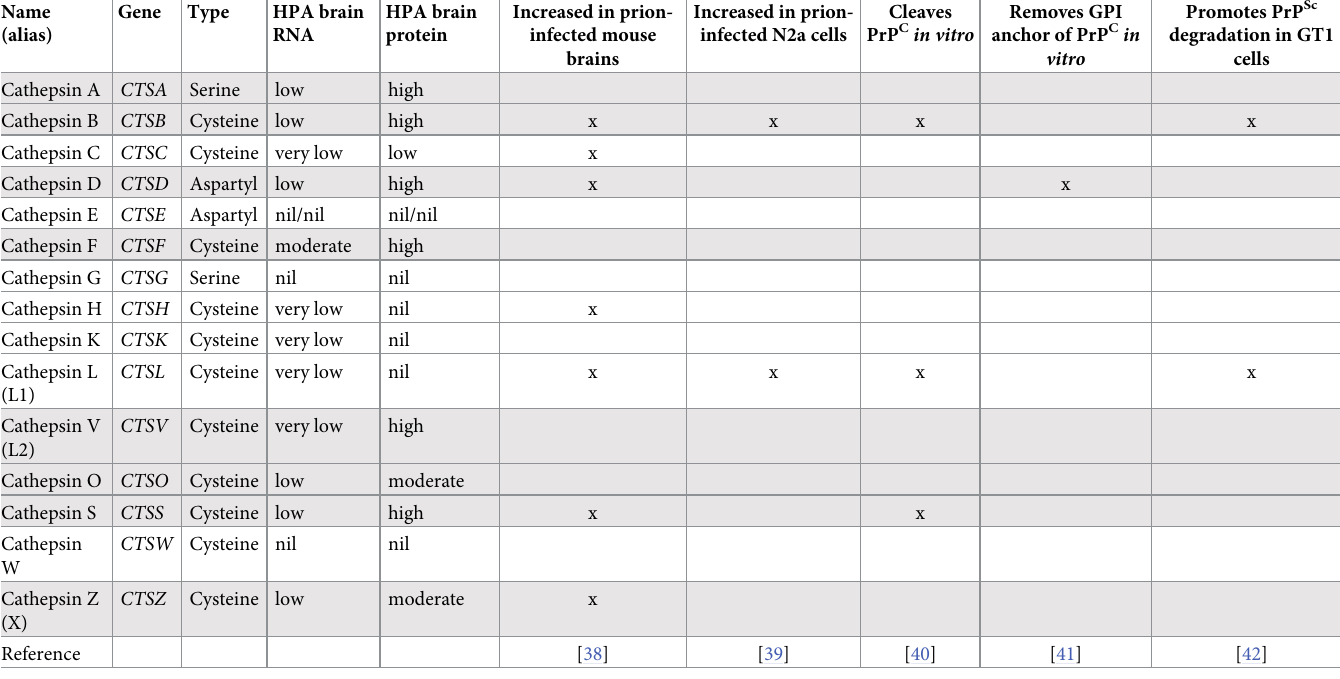
Table 1. Summary of information that guided the shortlisting of cathepsins for determining their possible involvement in the CG-dependent reduction of PrP C